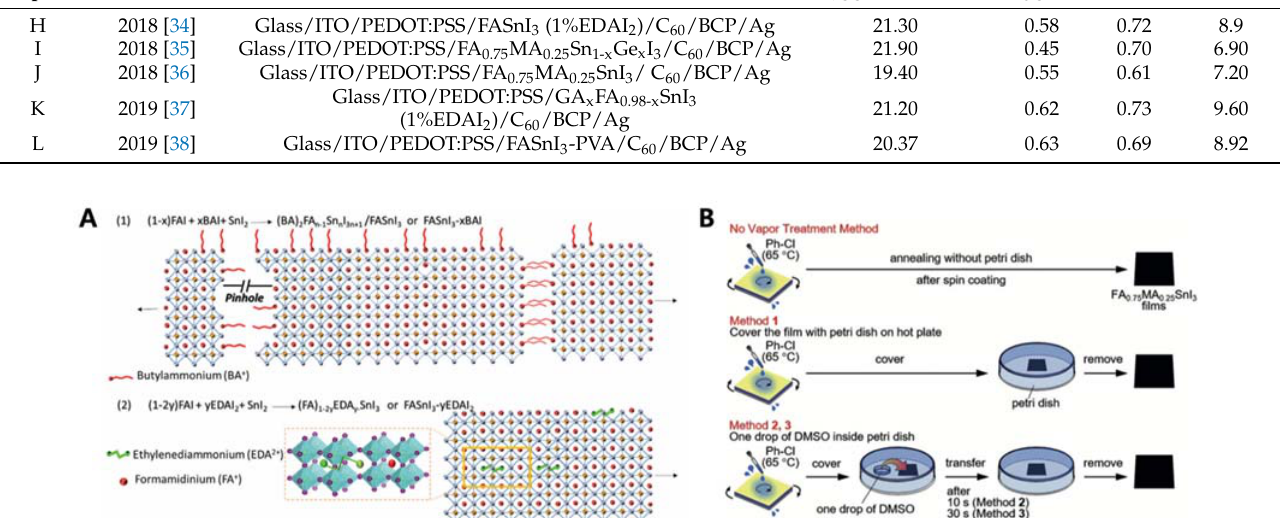
Figure 3. ( A ) Schematic representations of perovskite crystals in the presence of BAI and EDAI 2 additives. Reprinted with permission from ref. [34] Copyright 2018, the Royal Society of Chemistry. ( B ) Illustration of the vapour modification method discussed in this review. Reprinted with permission from ref. [36]. Copyright 2018, the John Wiley and Sons.